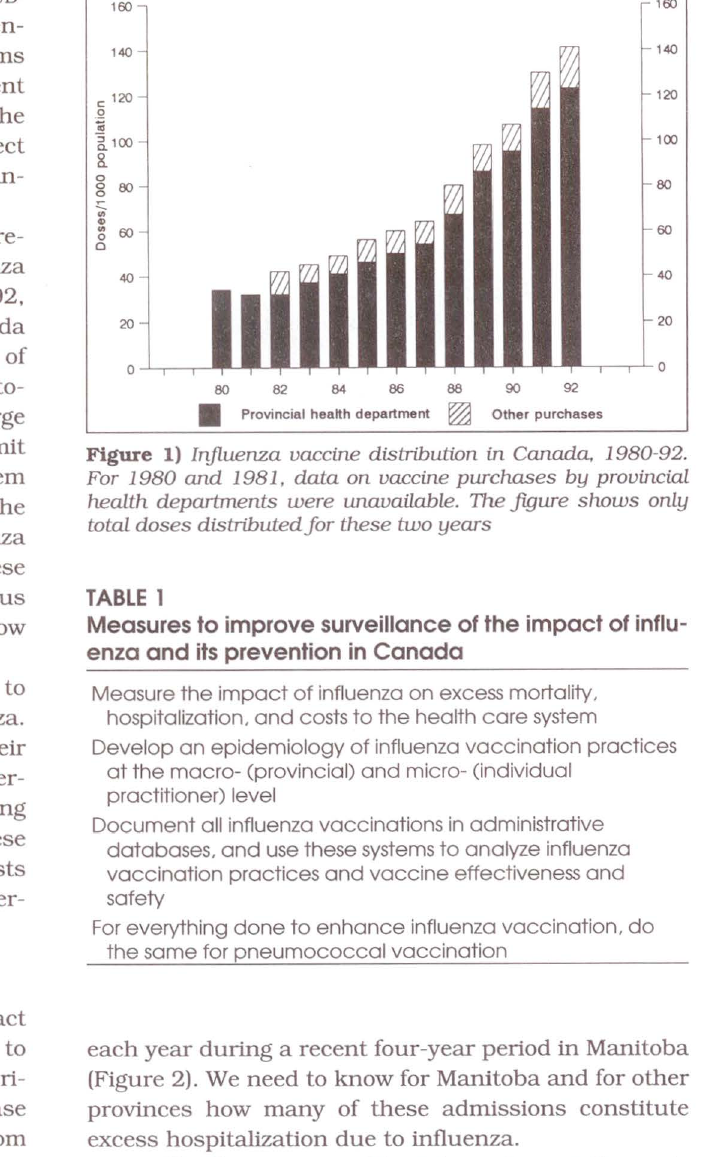
Figure 1) Influenza vaccine distribution in Canada. 1980·92. For 1980 and 1981, data on vaccine purchases by provincial health departments were unavailable. The figure shows only total doses distributed for these two years